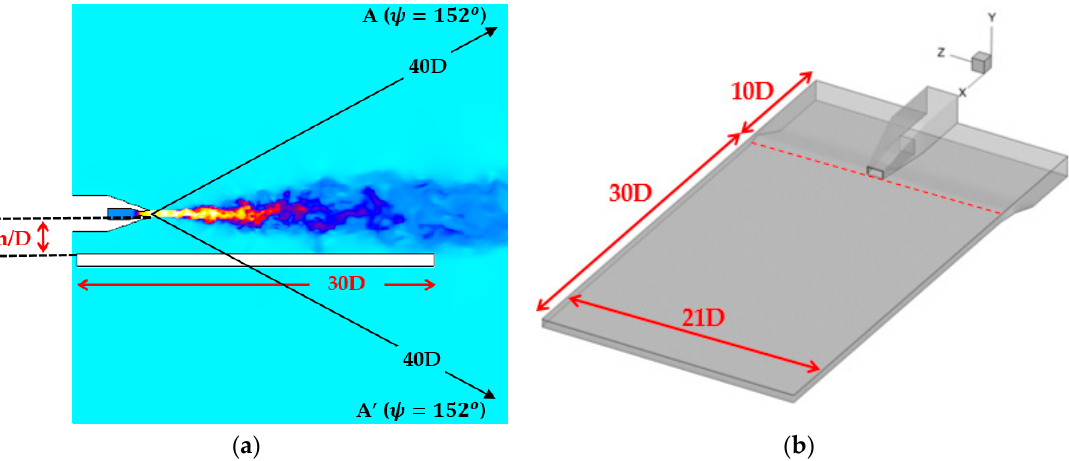
Figure 21. ( a ) Nozzle geometry cross-sectional (minor axis plane) and the location of far-field points. ( b ) Dimension of the flat plate.